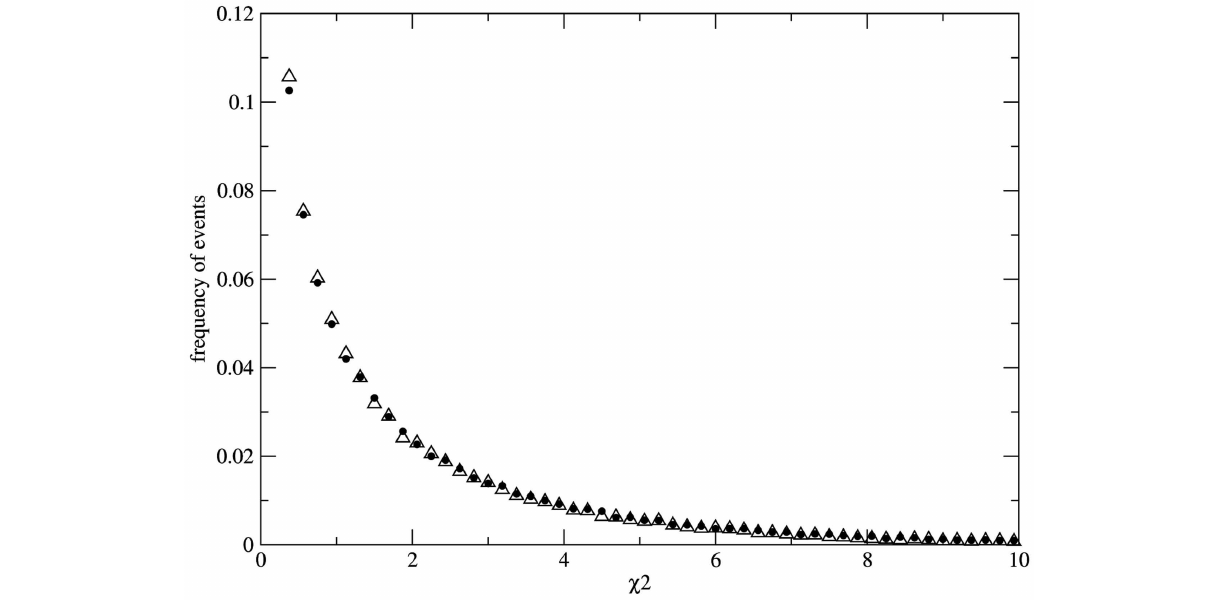
small deviation from the exponential function for small χ 2 values. Both distributions are very stable with respect to the size of the statistical ensemble.The distributions are used to evaluate the probability of false negative (for the case of random mating) and the probability of false positive (for the case of non-random